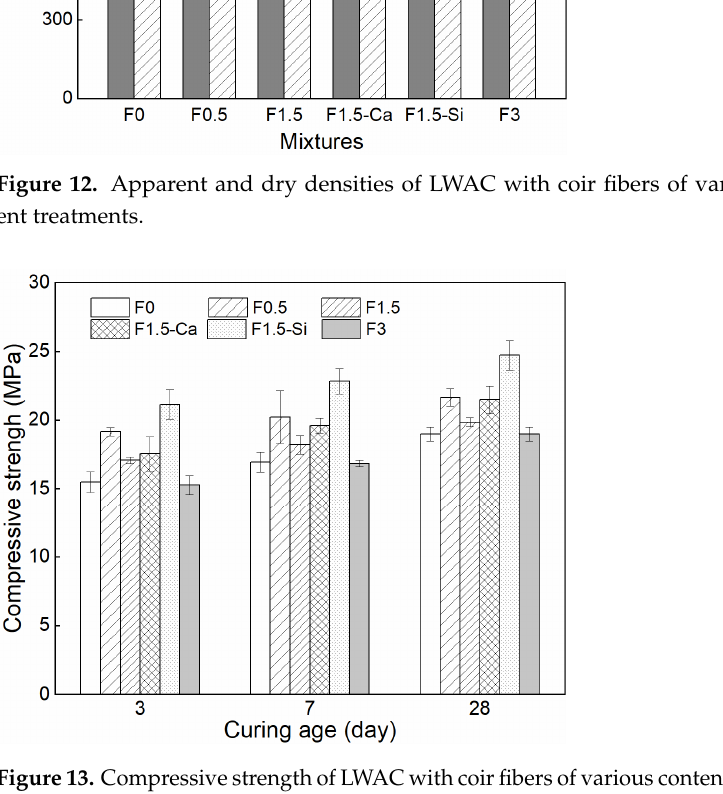
Figure 13. Compressive strength of LWAC with coir fibers of various contents and different treat- ments measured at 3, 7, and 28 days. However, when the coir fiber content further increases to 3%, no improvement is observed in the compressive strength. The explanations seem to be related to the mixing procedure, the porous structure of fibers, and the introduced ITZs between the fibers and matrix. More fibers tend to cause fiber agglomeration during mixing, and thus has a neg- ative effect on the compaction and homogeneity of the mixture [71,72], leading to reduced bonding between the fibers and matrix and increased flaws in the mixture. In addition, due to the cellular structure of coir fibers, a higher fiber content leads to larger porosity in